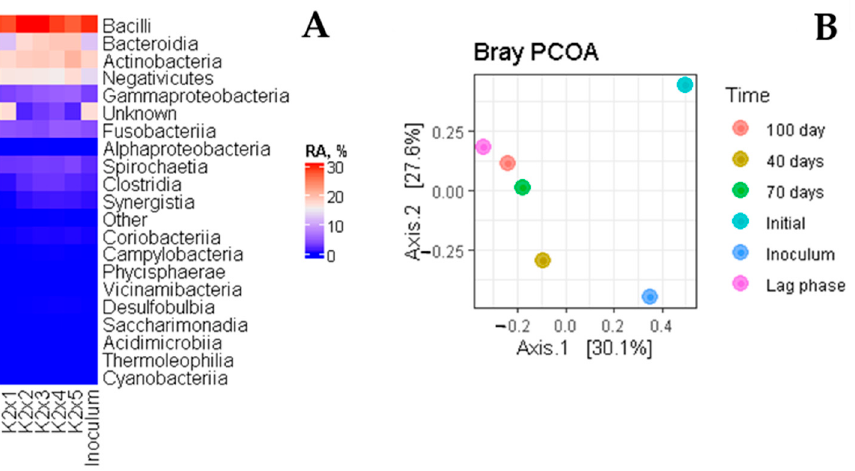
Figure 9. The bacterial community inside an electric composter. ( A ): heatmap at class taxonomic level, RA, relative abundance. ( B ): PCoA scatter plot.